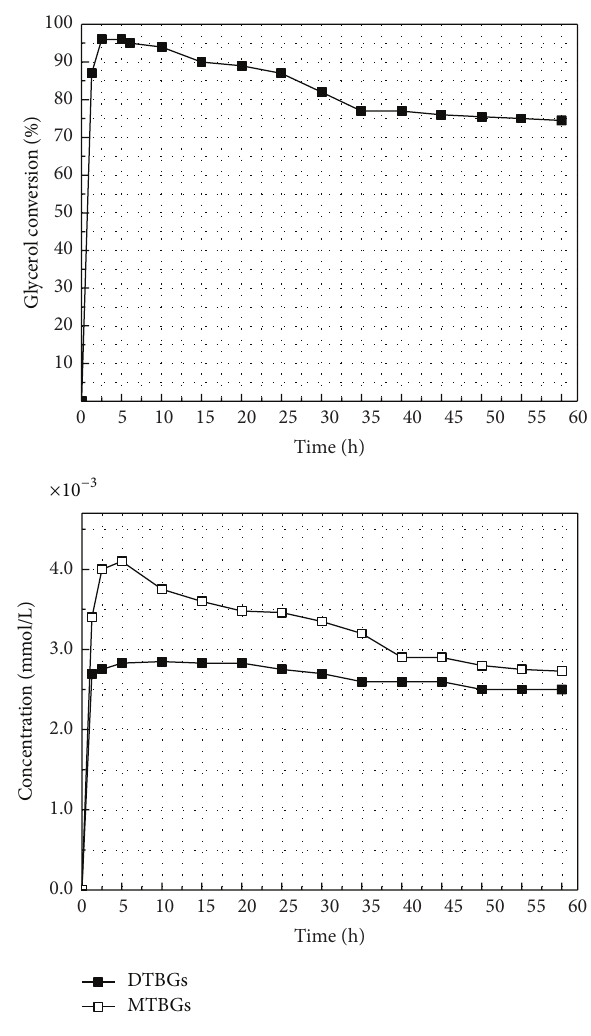
Figure 5: Glycerol conversion and products yields as a function of time. Reaction conditions: 70 ∘ C, TBA to glycerol molar ratio = 4 :1; Amberlyst 15 catalyst = 7.5 wt.% to